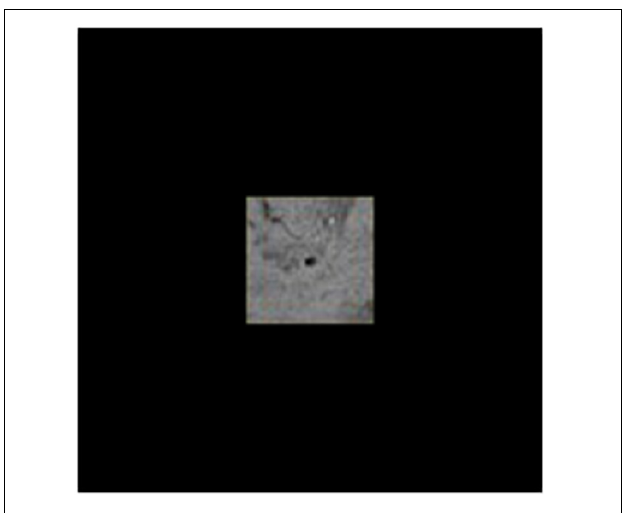
FIGURE 6 | Images padded for DenseNet.